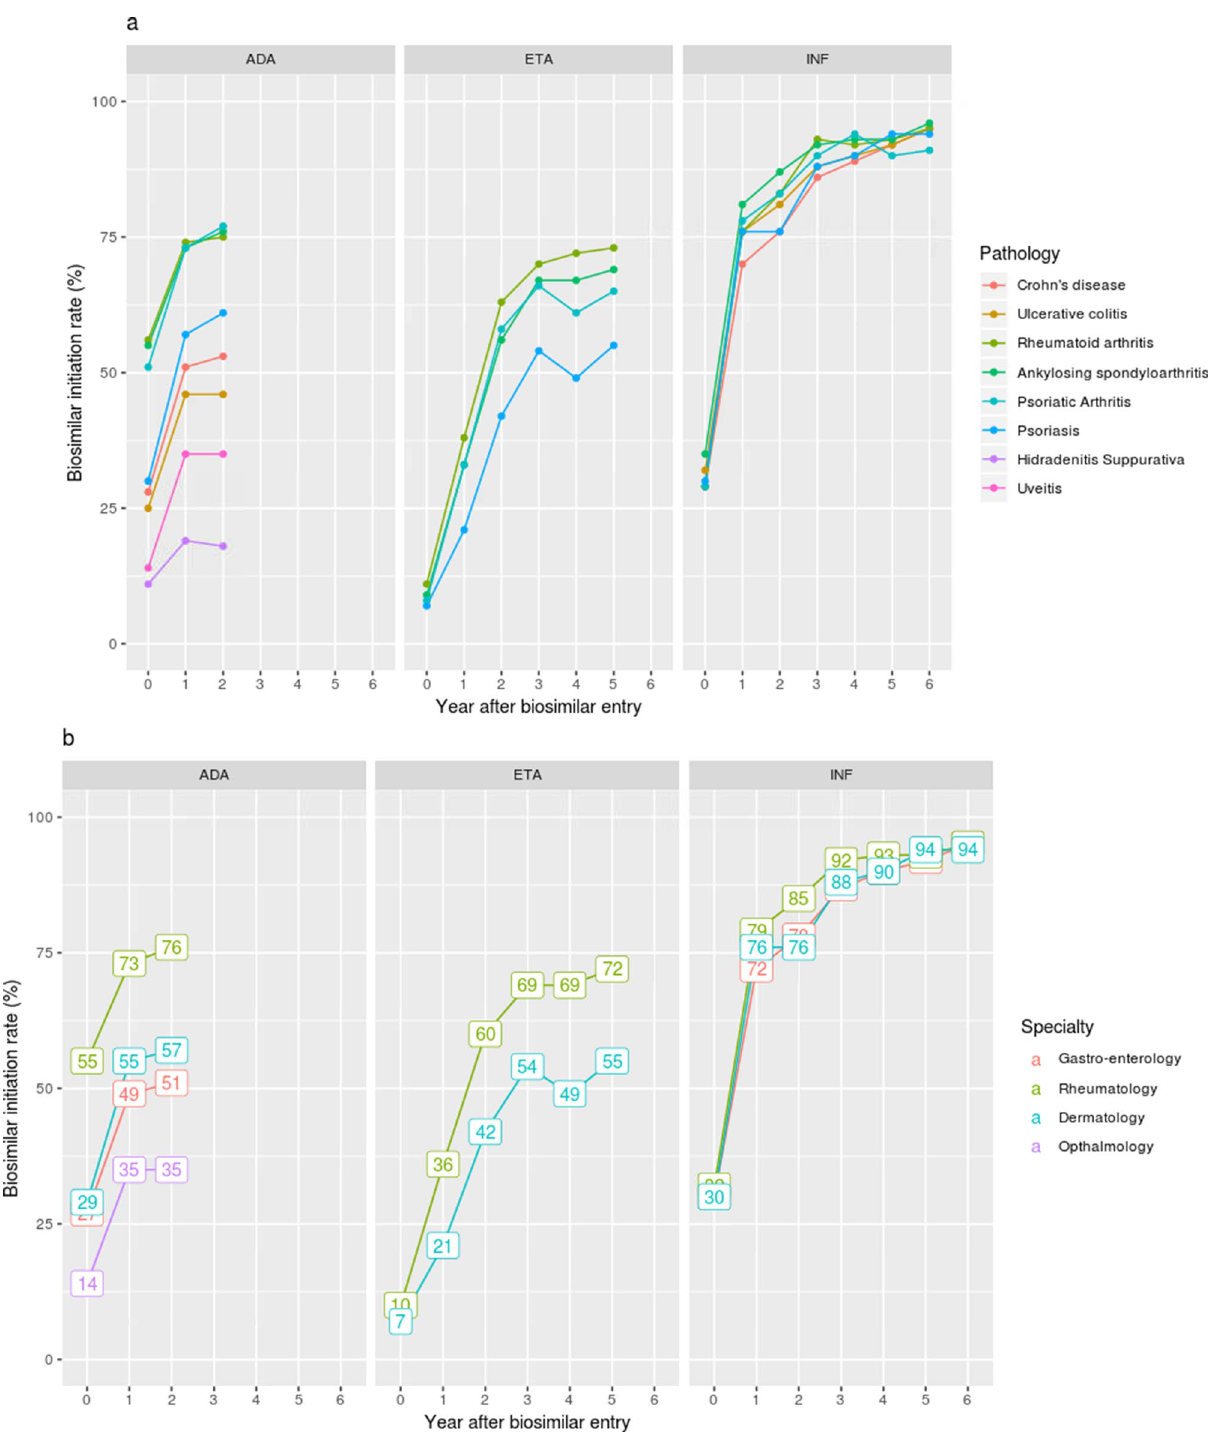
Figure 4. TNF-alpha inhibitors’ biosimilar initiation rate by pathology ( a ) and specialty ( b ) between year 0 and 6 (if applicable) after first biosimilar entry for each molecule. ADA, ETA and INF refer to adalimumab, etanercept and infliximab